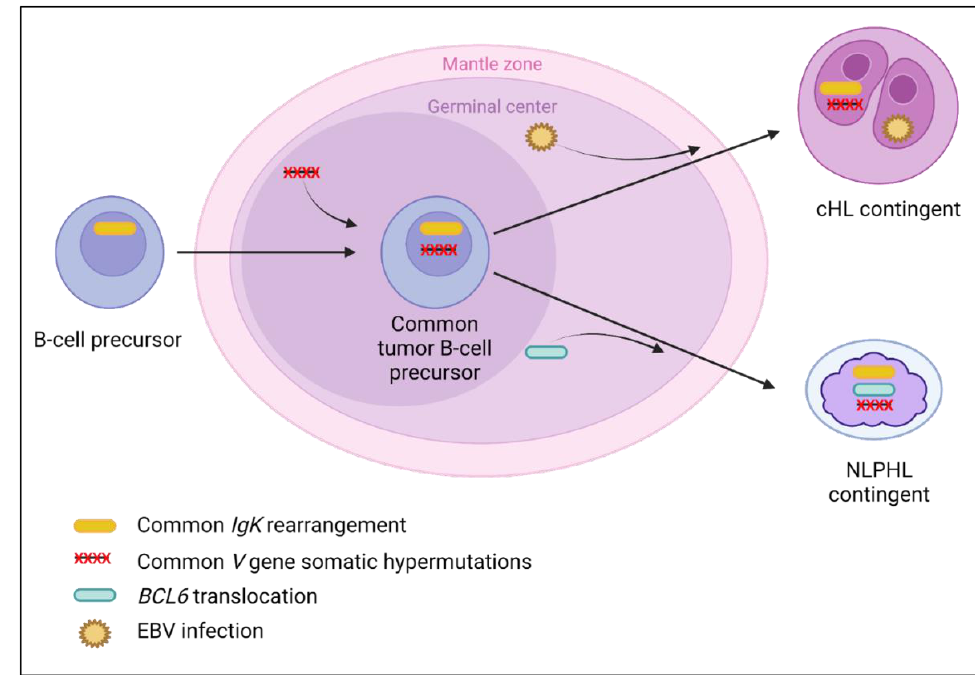
Figure 5. Suggested lymphomagenesis model for classical Hodgkin lymphoma (cHL)/nodular lym- phocyte-predominant Hodgkin lymphoma (NLPHL) composite lymphomas. Both contingents of these lymphomas come from the germinal center [123]. The presence of similar clonal rearrange- ments of IgK only with polyclonal IgH rearrangements [106], or identical V gene somatic hypermu- tations [107] between both contingents, suggest that the lymphomagenesis of this entity takes place in the germinal center, or after this step. Indeed, the V gene somatic hypermutations, arising in the germinal center [123], could interfere with the detection of similar IgH rearrangements by avoiding the hybridization of PCR primers on the variable regions. Then, after the germinal center step, ad- ditional molecular abnormalities could occur to form both contingents with specific molecular al- terations. These abnormalities could be (i) the BCL6 translocation, which is the hallmark of NLPHL, leading to the BCL6 overexpression reported in two cases, without BCL6 expression in the cHL contingent [106,107]; and/or (ii) EBV infection in cHL, absent in the NLPHL contingent [106]. How- ever, few molecular data are available for this composite lymphoma, which complicates lym- phomagenesis understanding.